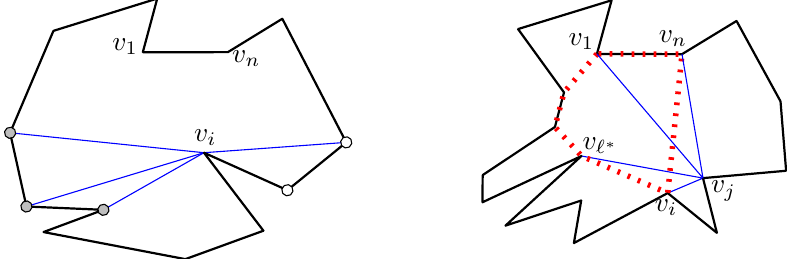
Figure 4: Left: Vertices filled in gray belong to J <i , while vertices filled in white belong to J >i . Right: Vertex v j can be added to the clique associated to O PT [ (cid:96) ∗ , i ] (whose lateral edges are dotted) because it is visible from v (cid:96) v 1 , and v n